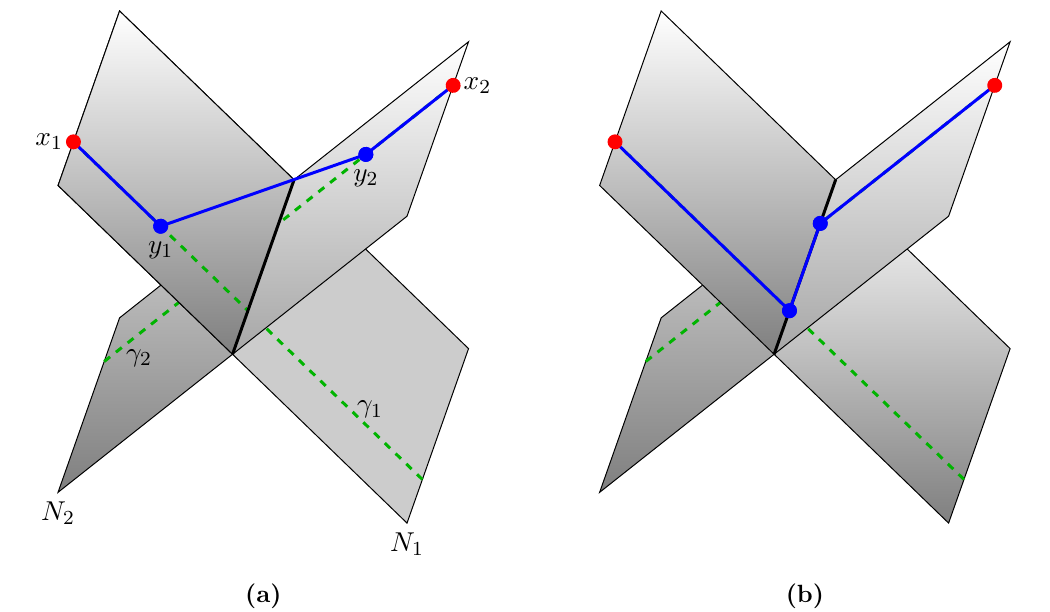
Figure 2. a) Calculation of Entanglement Entropy before extremizing. The red boundary points x i are connected to the blue points y i , which live at the null lines (cid:13) i . b) Geometrical picture after extremizing the total length. The bulk points live at the intersections N 1 \ N 2 \ (cid:13) i . geodesic path with corners.